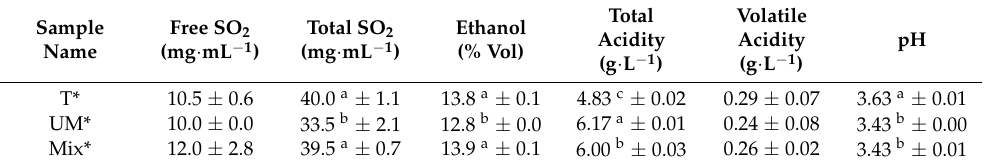
Table 1. Average values for oenological parameters for all Ant ã o Vaz wines. Frozen unripe grape must addition (UM*); addition of a mixed solution of tartaric, malic, and lactic acid (Mix*); testimonial wine